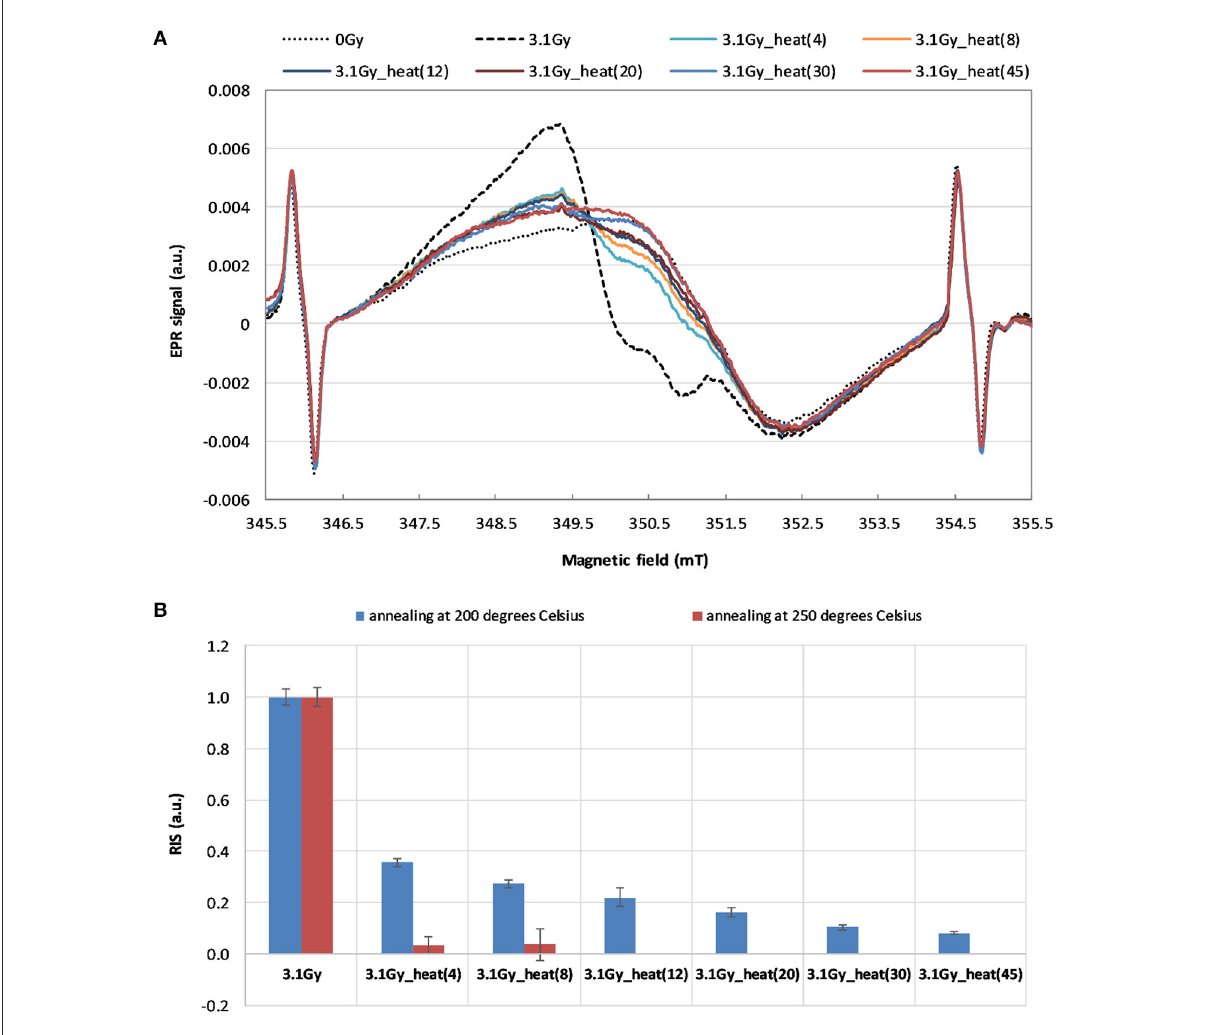
FIGURE6 (A) The effect of time of annealing at 200 ◦ C on the EPR spectra of the irradiated sample (3.1 Gy 232 in glass). (B) The dependence of the RIS component on duration of the annealing at 200 ◦ C (for 4, 8, 12, 233 20, 30 and 45 min) and at 250 ◦ C (for 4 and 8 min). The spectra in (A) and the data in (B) were marked according to headings of the respective columns in Table